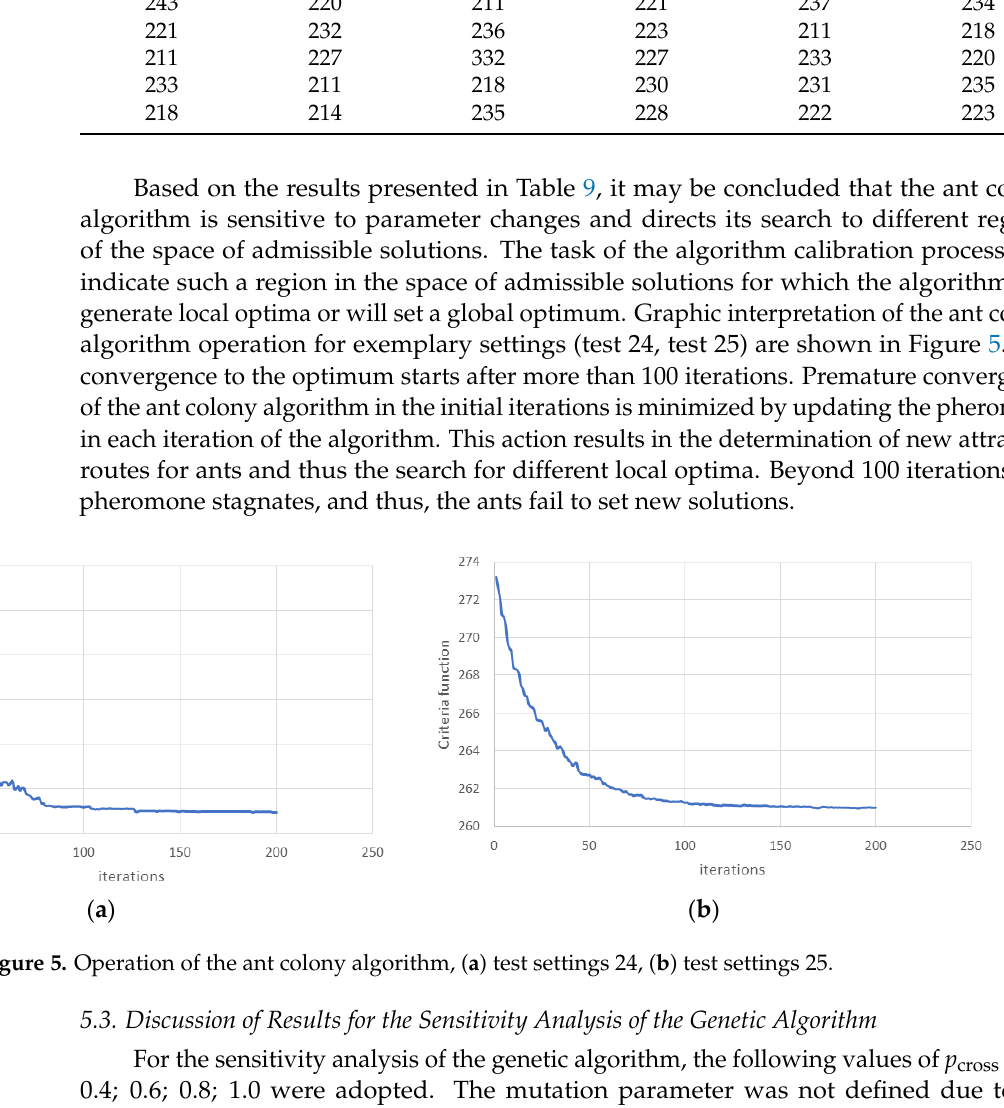
Table 11. Test input parameters of the genetic algorithm [kWh].